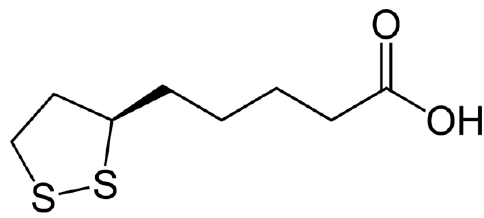
Figure 1. Structural formula of α -lipoic acid.